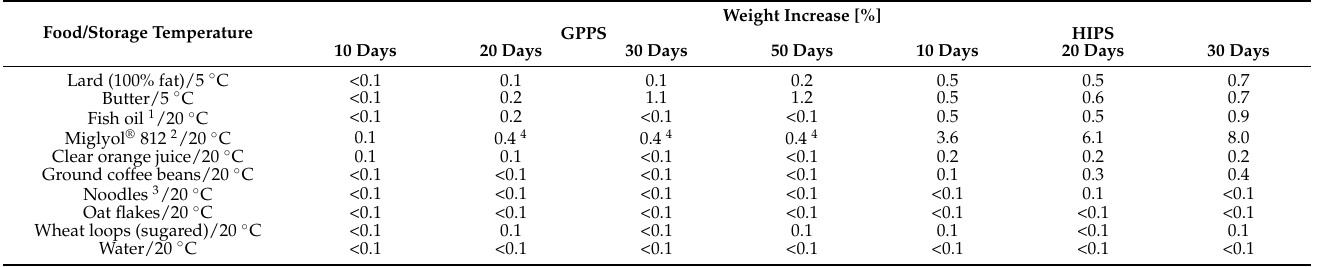
Table 4. Weight increase [%] of GPPS and HIPS after contact with real foods at 5 ◦ C and 20 ◦ C up to storage for 50 or 30 days.